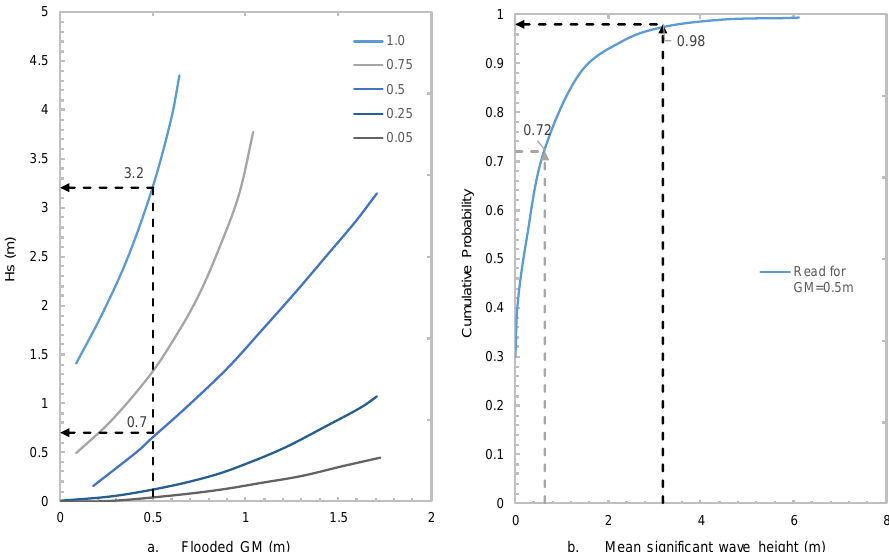
Figure 3. Method of deriving limiting sea-state and survival index s : ( a ) Hs vs. flooded GM for different freeboards (for example at flooded GM = 0.5 and freeboard = 1.0 m), limiting Hs = 3.2 m. For the same flooded GM and freeboard = 0.5 m, limiting Hs = 0.7 m; ( b ) cumulative probability distribution (CPD) of Hs at occurrence of capsize (from accident statistics). At Hs = 3.2 m, the probability is 0.98 (hence exceedance probability 0.02) and at Hs = 0.7 m, the probability is 0.72 (hence exceedance probability 0.28).